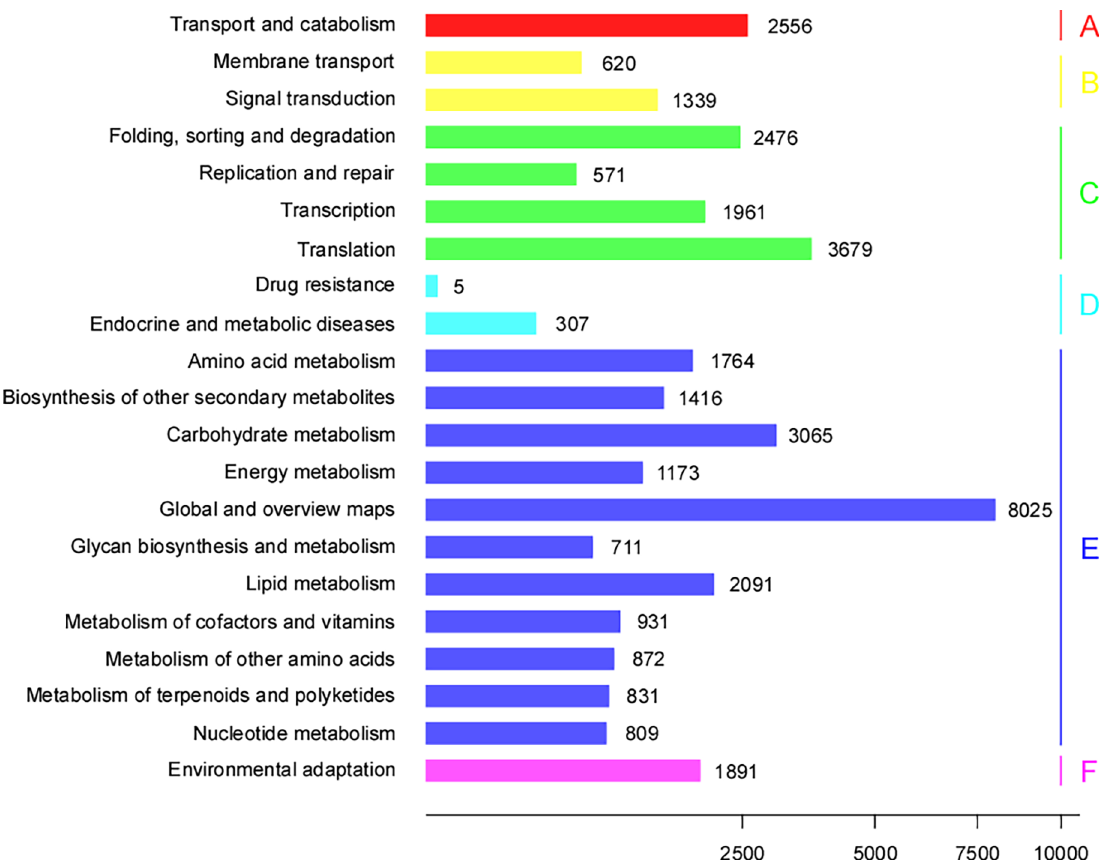
Fig 1. Functional distribution of the KEGG annotation. X-axis represents the numbers of unigenes. Y-axis represents the KEGG functional category. A, cellular processes; B, environmental information processing; C, genetic information processing; D, human diseases; E, metabolism; and F, organismal